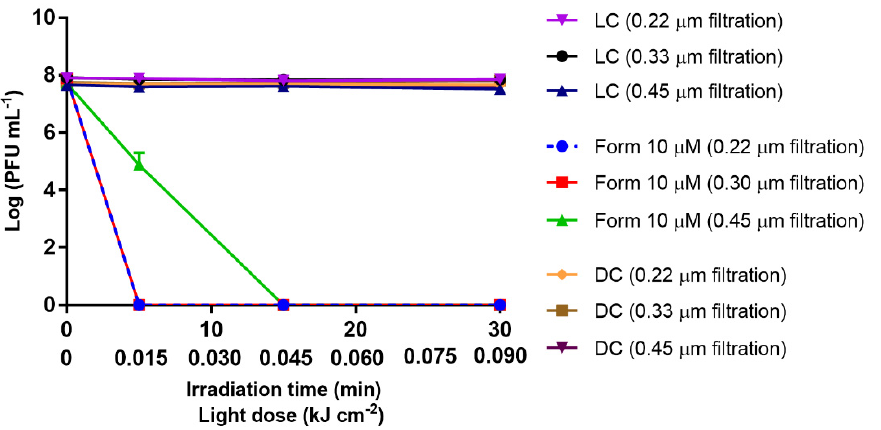
Figure 2. Inactivation of T4-like bacteriophage during aPDT, in filtered WW (0.22, 0.30, and 0.45 µ m pore size filtration) with Form at 10 µ M, for 30 min of irradiation with white light (50 mW cm − 2 ). The values are expressed as the mean of three independent experiments; error bars represent the standard deviation (SD) between the experiments. In some cases, SD bars are covered behind the symbols and lines just join the experimental points.